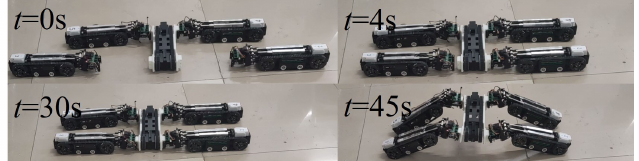
Figure 18. Experiments on the self-assembly of a quadruped structure.